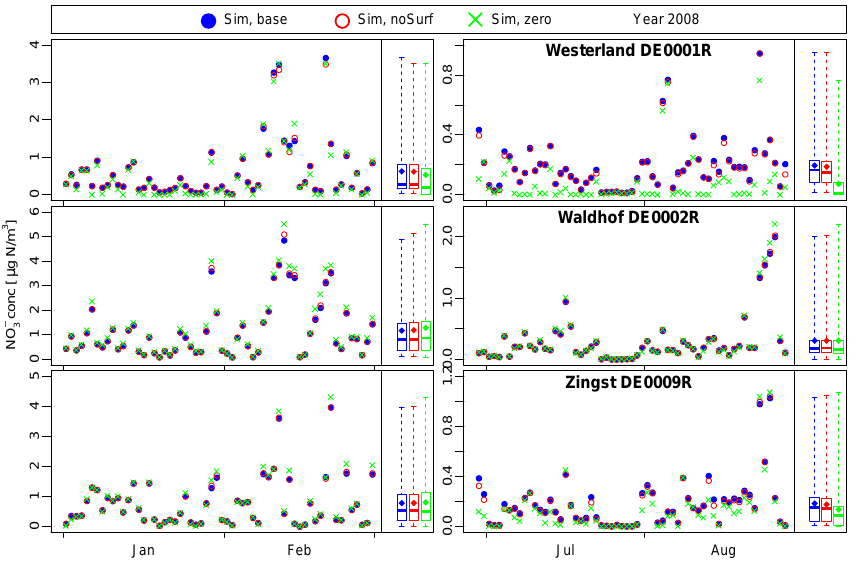
Figure 8. Similar to Fig. 6 but showing NO −